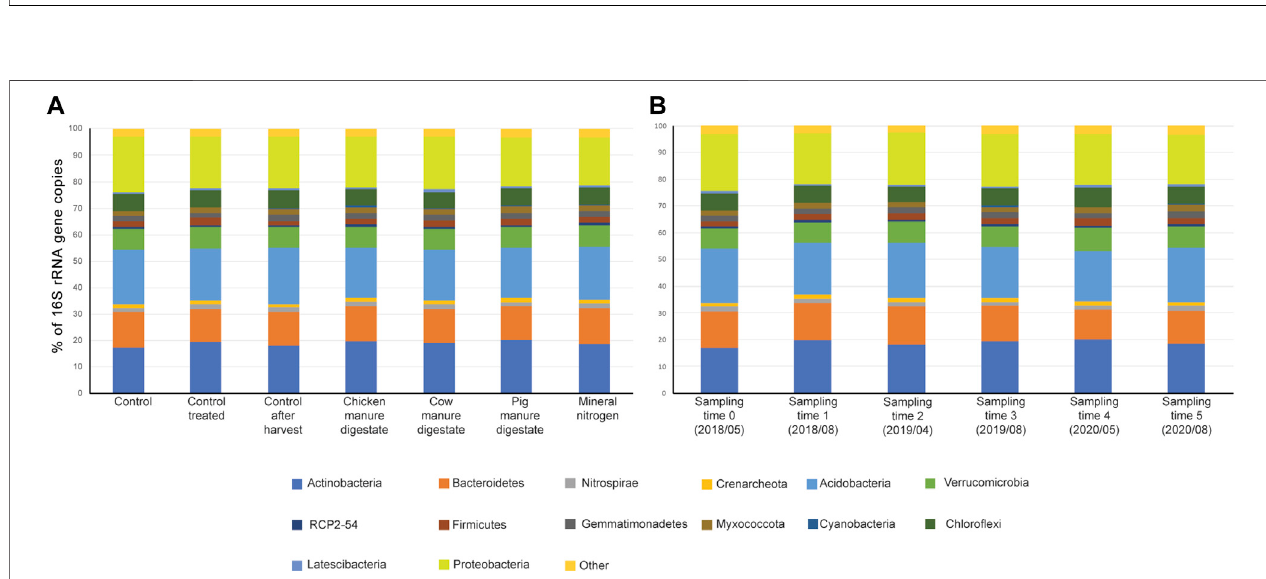
FIGURE 3 | Soil prokaryotic composition. Soil prokaryotic community composition with respect to (A) the treatment used or (B) sampling time. The fi fteen major groups are reported at the phylum taxonomic level. Other phyla are collapsed within the group “ other ” .